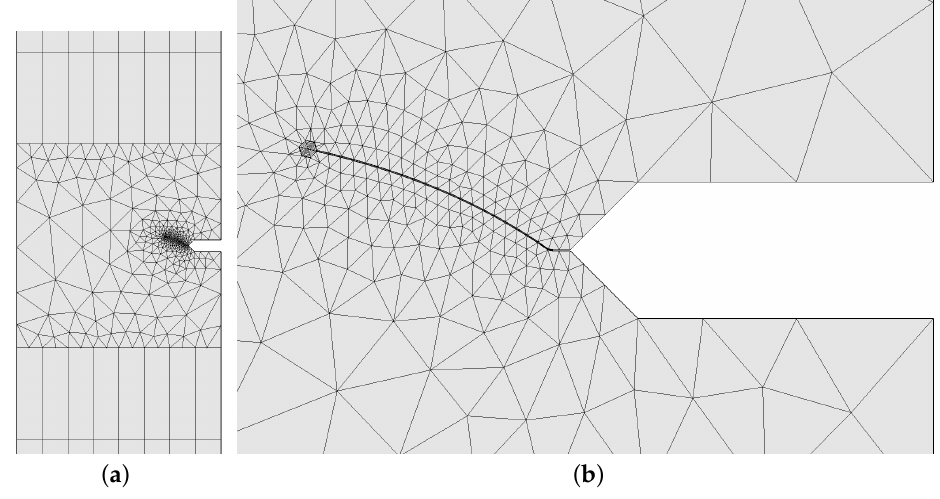
Figure 4. ( a ) Mesh of the cracked tension-torsion specimen. ( b ) Detail of the domain. The innermost layer of hexahedral elements adjacent to the crack front are so-called collapsed quarter-point elements [43,44]. These are regular 20-node brick elements, one face of which is collapsed to a line. The 8 nodes in this face are reduced to 3, i.e., one and the same node may occur more than once in the element topology. Furthermore, mid-nodes on edges having one node in common with the crack front are moved into a quarter-point √ r singularity typical for the position. It has been proven that these elements exhibit the 1/ stress and strain field at the crack tip in linear elastic